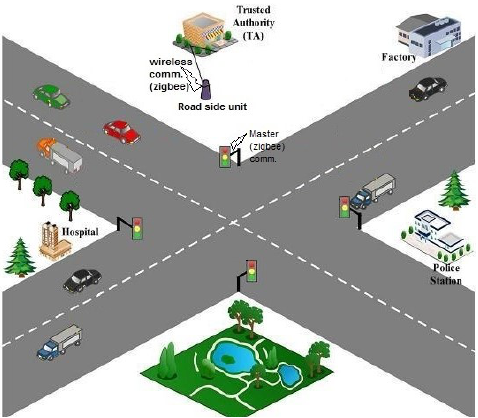
Fig.2 Purposed interconnected